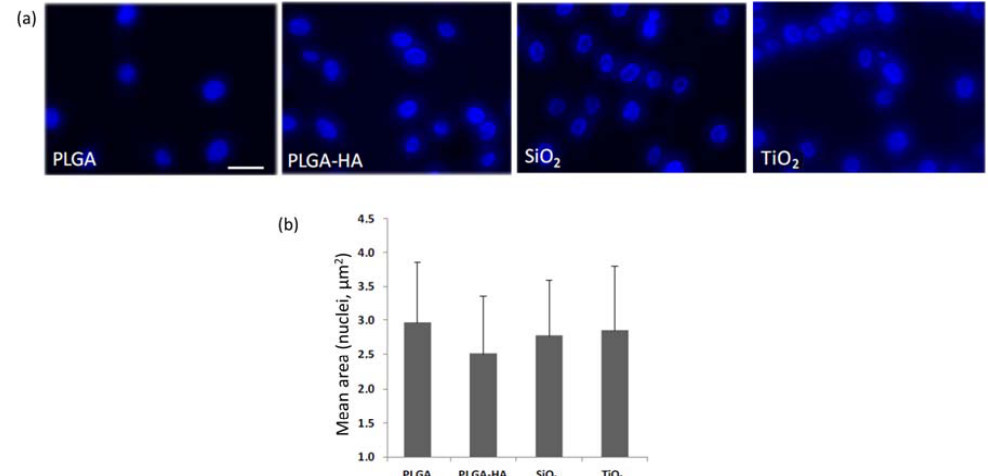
Figure 4. ( a ) Microphotography of the osteoblasts on studied membranes stained with phalloidin- TRITC 50 (red) and DAPI (blue). ( b ) The mean + SD of the areas of the cells adhered to the membranes is shown. Bar in PLGA = 10 microns (same scale for all images).